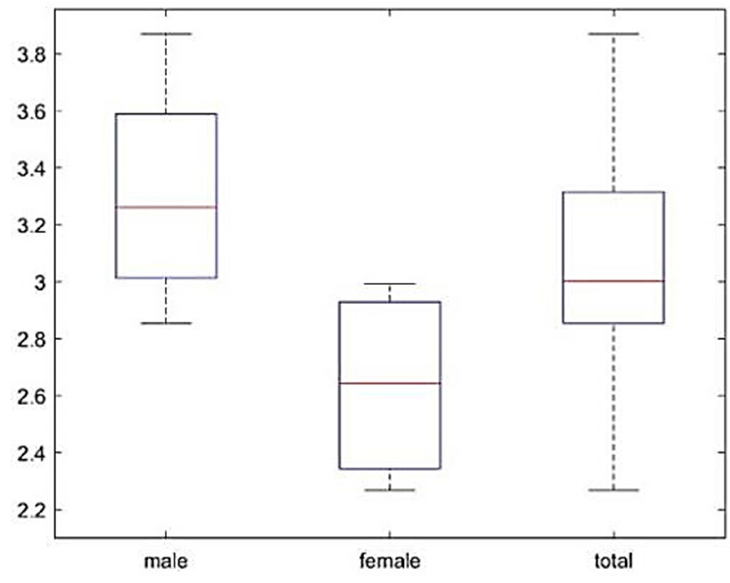
Figure 6. Comparison of various types of drivers. Table 6. Normal distribution test result of fixation entropy rate value.